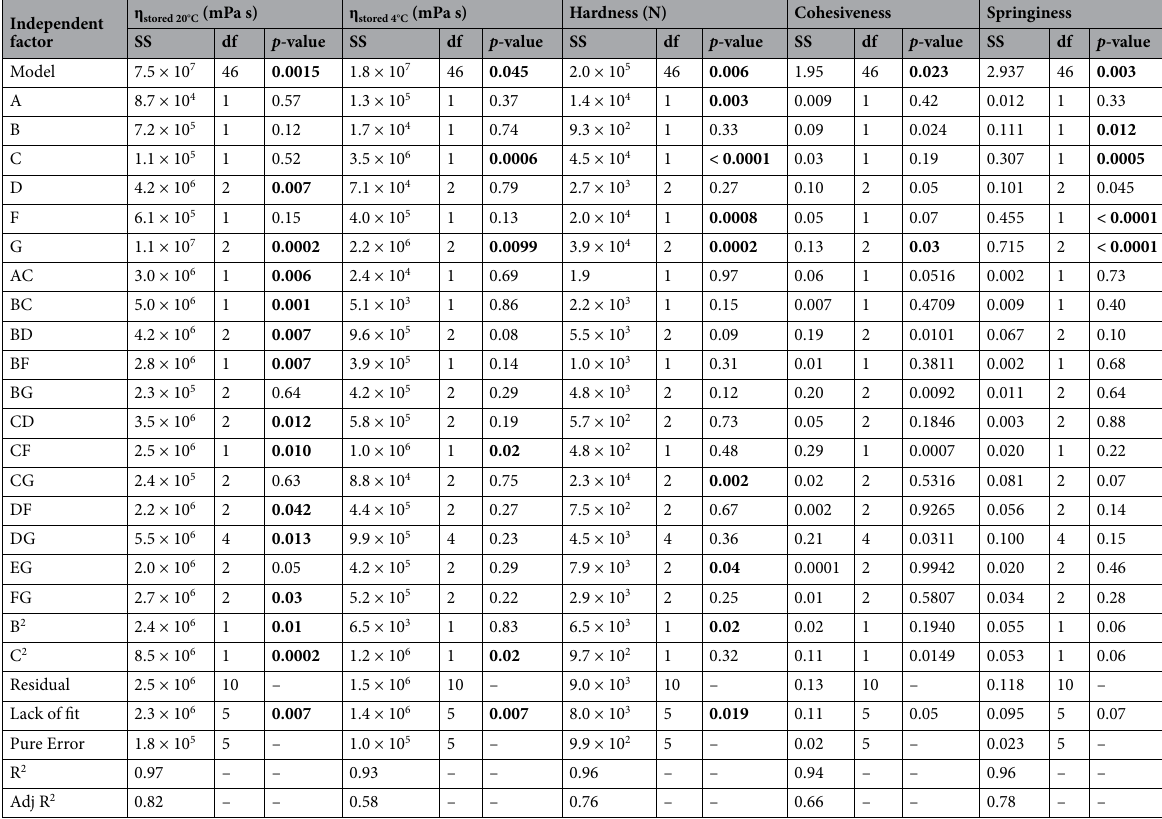
Table 3. ANOVA for the adjusted variables to response optimization design η for stored emulsions at 20 °C and 4 °C, and hardness, cohesiveness and springiness of oleogels. Values in bold represent p values lower than 0.05 which have a significant